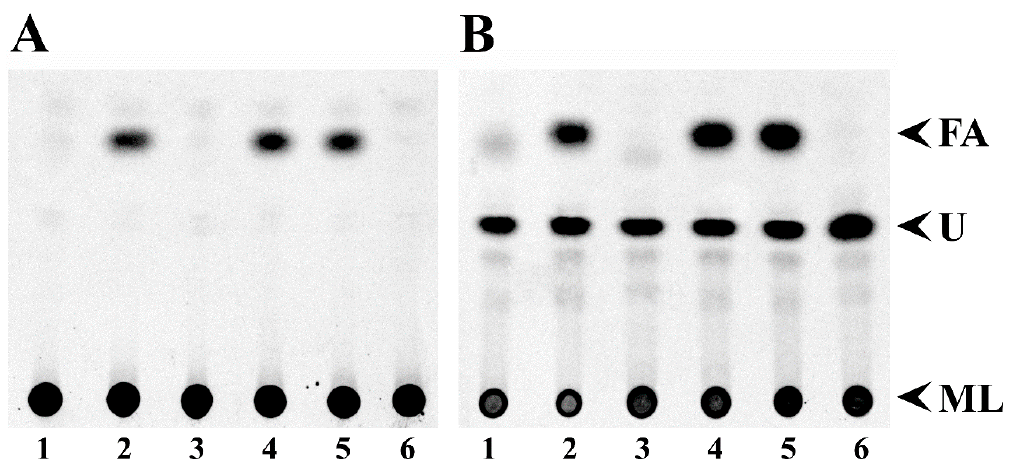
Figure 3. Expression of sma0150 or smb20650 does not abolish free fatty acid accumulation in fadD mutants of E. coli . TLC analyses of cellular lipid extracts ( A ) and lipid extracts of spent media ( B ) obtained either from wild type E. coli BL21 (DE3) pLysS carrying the empty vector pET17b (lane 1) or from its fadD mutant BfadD1 pLysS carrying pET17b (lane 2), pECH8 ( fadD Ecoli , lane 3), pECH1 ( sma0150 , lane 4), pECH7 ( smb20650 , lane 5), or pECH6 ( smc02162 , lane 6), grown on M9 MM for 26 h. The membrane lipids (ML) did not migrate from the origin, and the spot for fatty acids (FA) is indicated. U: unidentified lipid spot. A single experiment representative of three repetitions is shown.